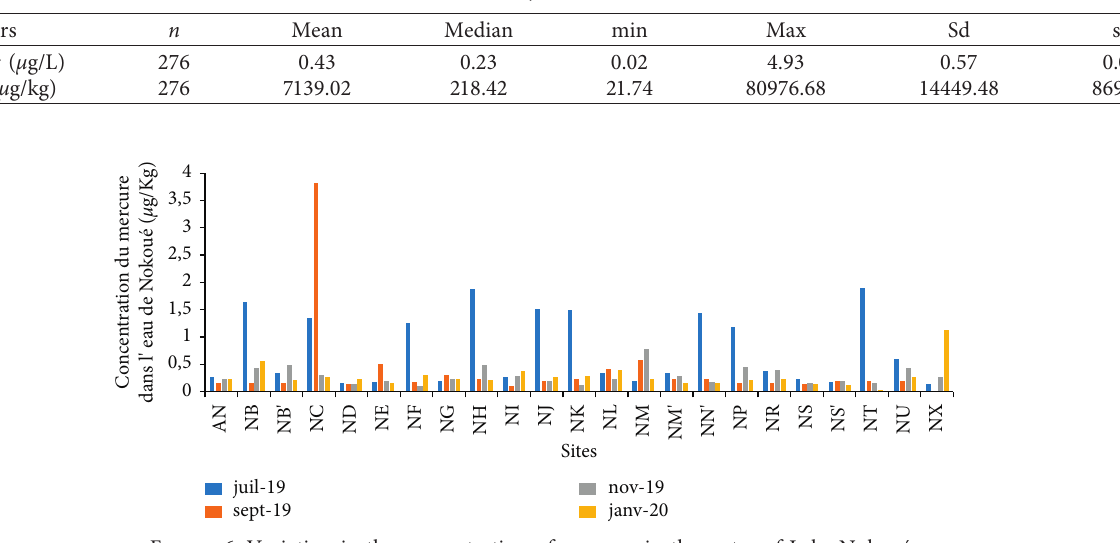
Table 3: Statistical data of the mercury concentration in water and sediment.